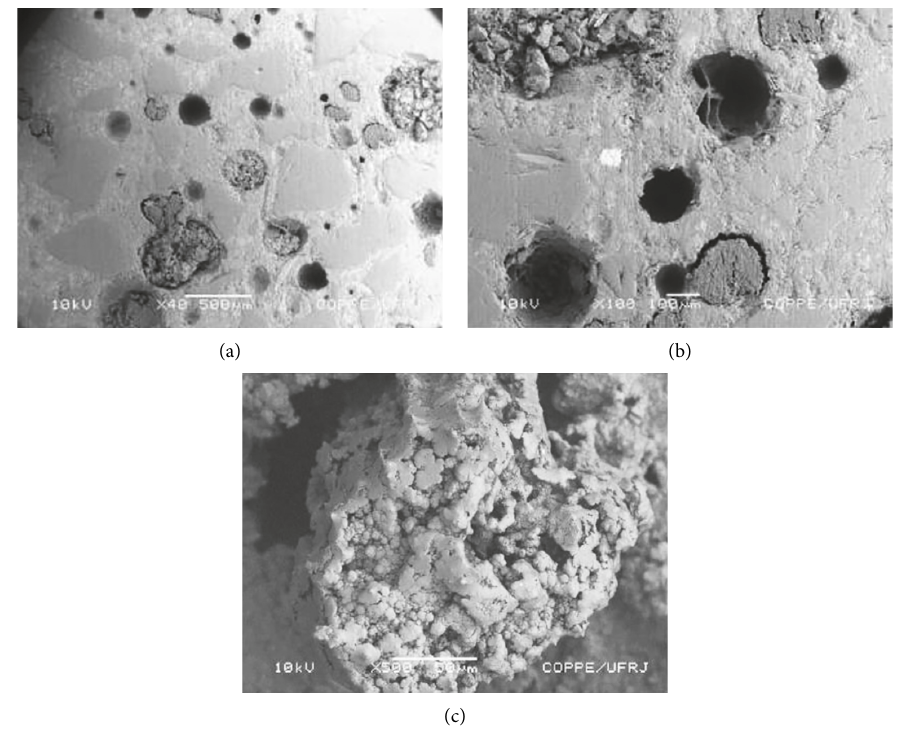
Figure 4: Micrographs of aged Portland cement specimens: (a) when subjected to 25 wetting and drying cycles; (b) cavities in the matrix due to sisal fibers breaking and pull-out; (c) mineralized fiber inside the specimen [87]. Reproduced with permission from Elsevier.